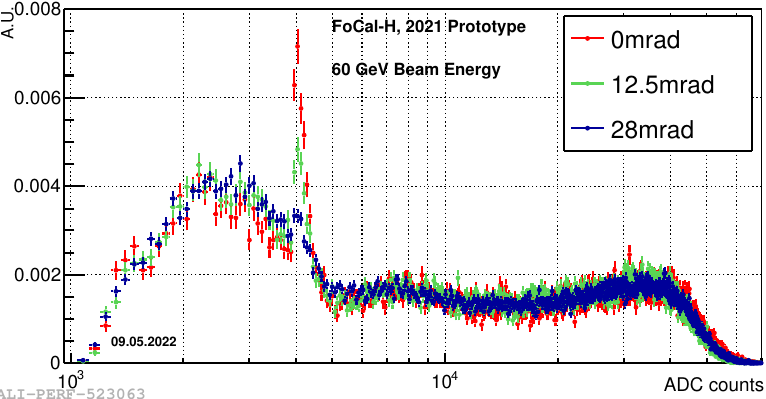
Figure 4. The peak corresponding to a particle traveling along the fiber decreases with the increase of the angle between the detector and the beam axis and almost vanishes at 28 mrad. For the subsequent results data taken with a spacer providing 28 mrad inclination was